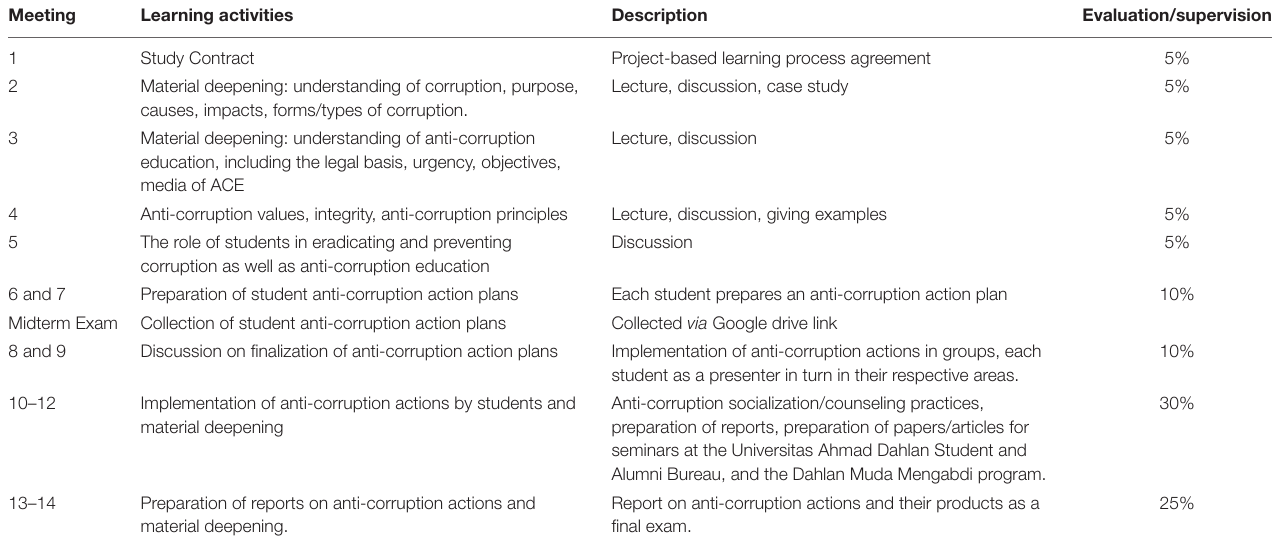
TABLE 1 | ACE learning process based on an anti-corruption action